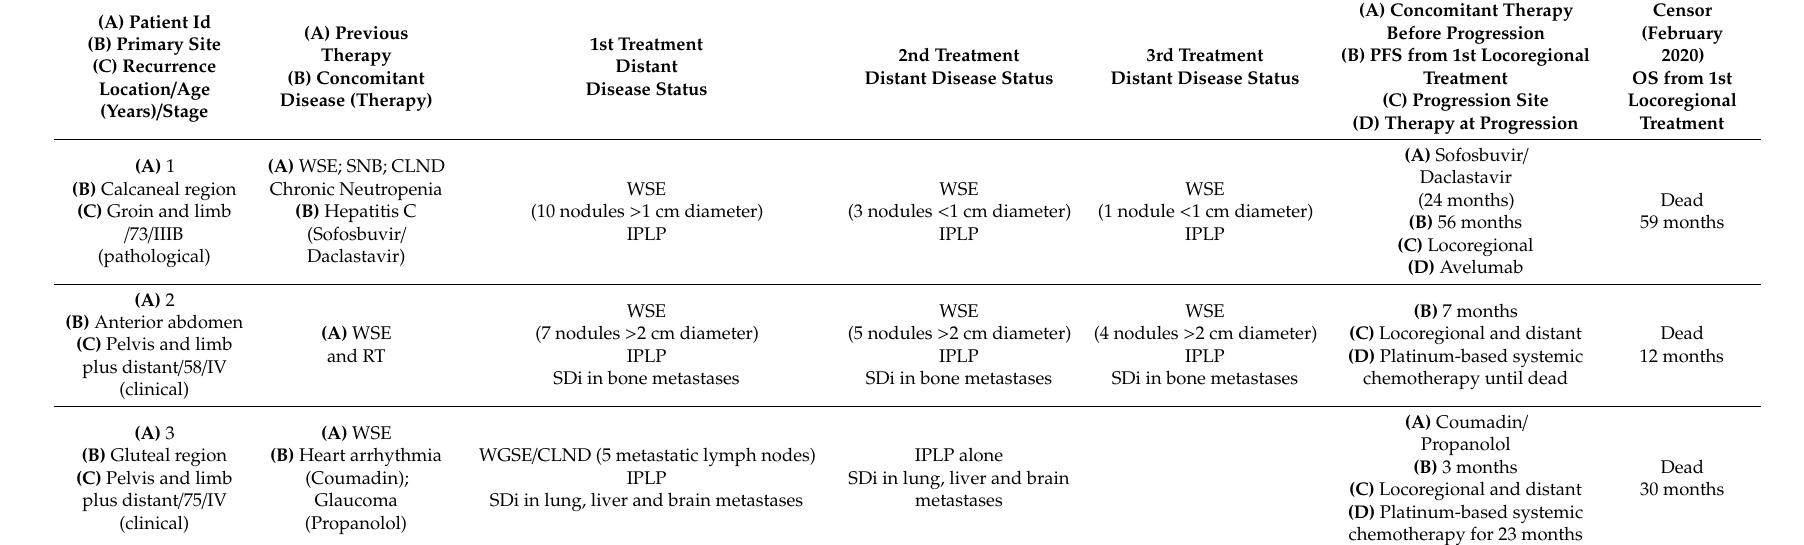
Table 2. Clinical characteristics of three advanced-stage MCC patients submitted for locoregional chemotherapy during multidisciplinary